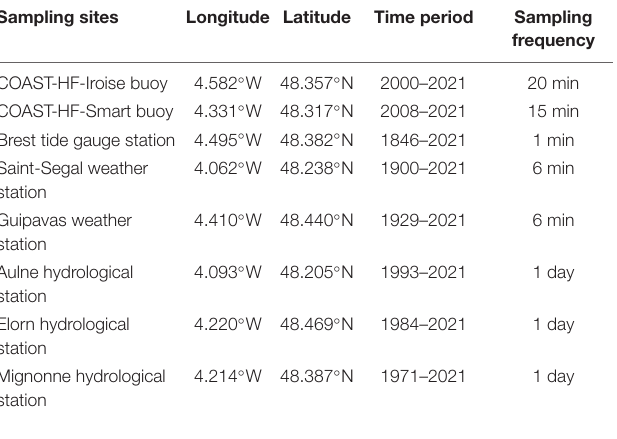
TABLE 1 | Locations and characteristics of the in situ sampling sites. Sampling